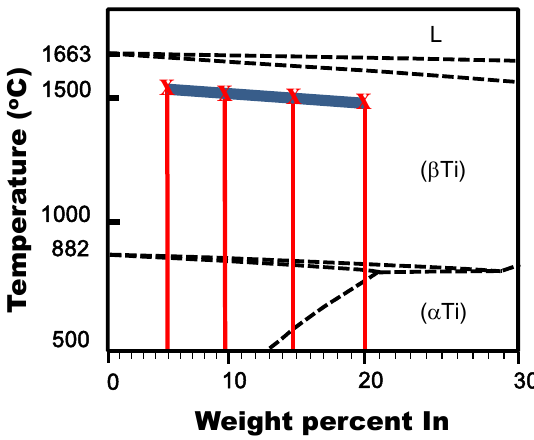
Figure 1. Ti-rich portion of the Ti–In system according to the published Ti-In equilibrium phase diagram [28]. The four alloys investigated and the temperature ranges of heat-treatment are